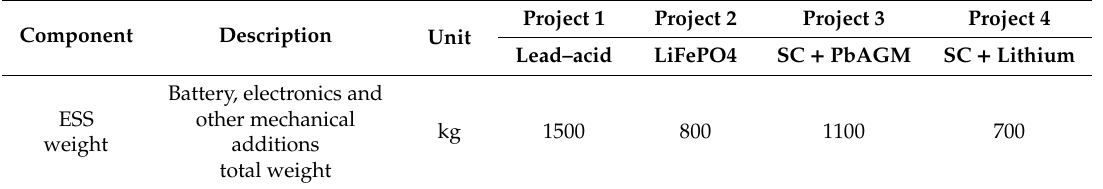
Table 5. ESS weight in the projects.